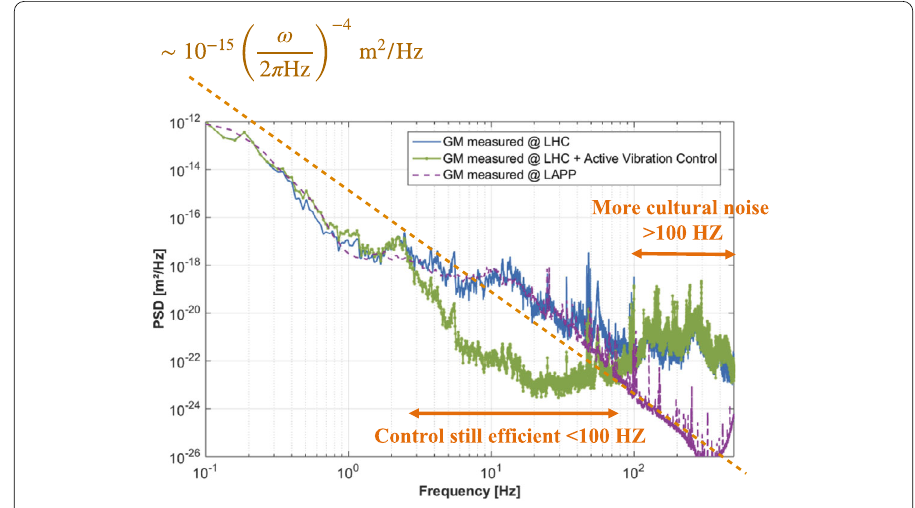
Figure 13 A ground vibration measurement performed at CERN site by M. Serluca, et al. [25]. The dashed line is a rough fit of the spectrum by these